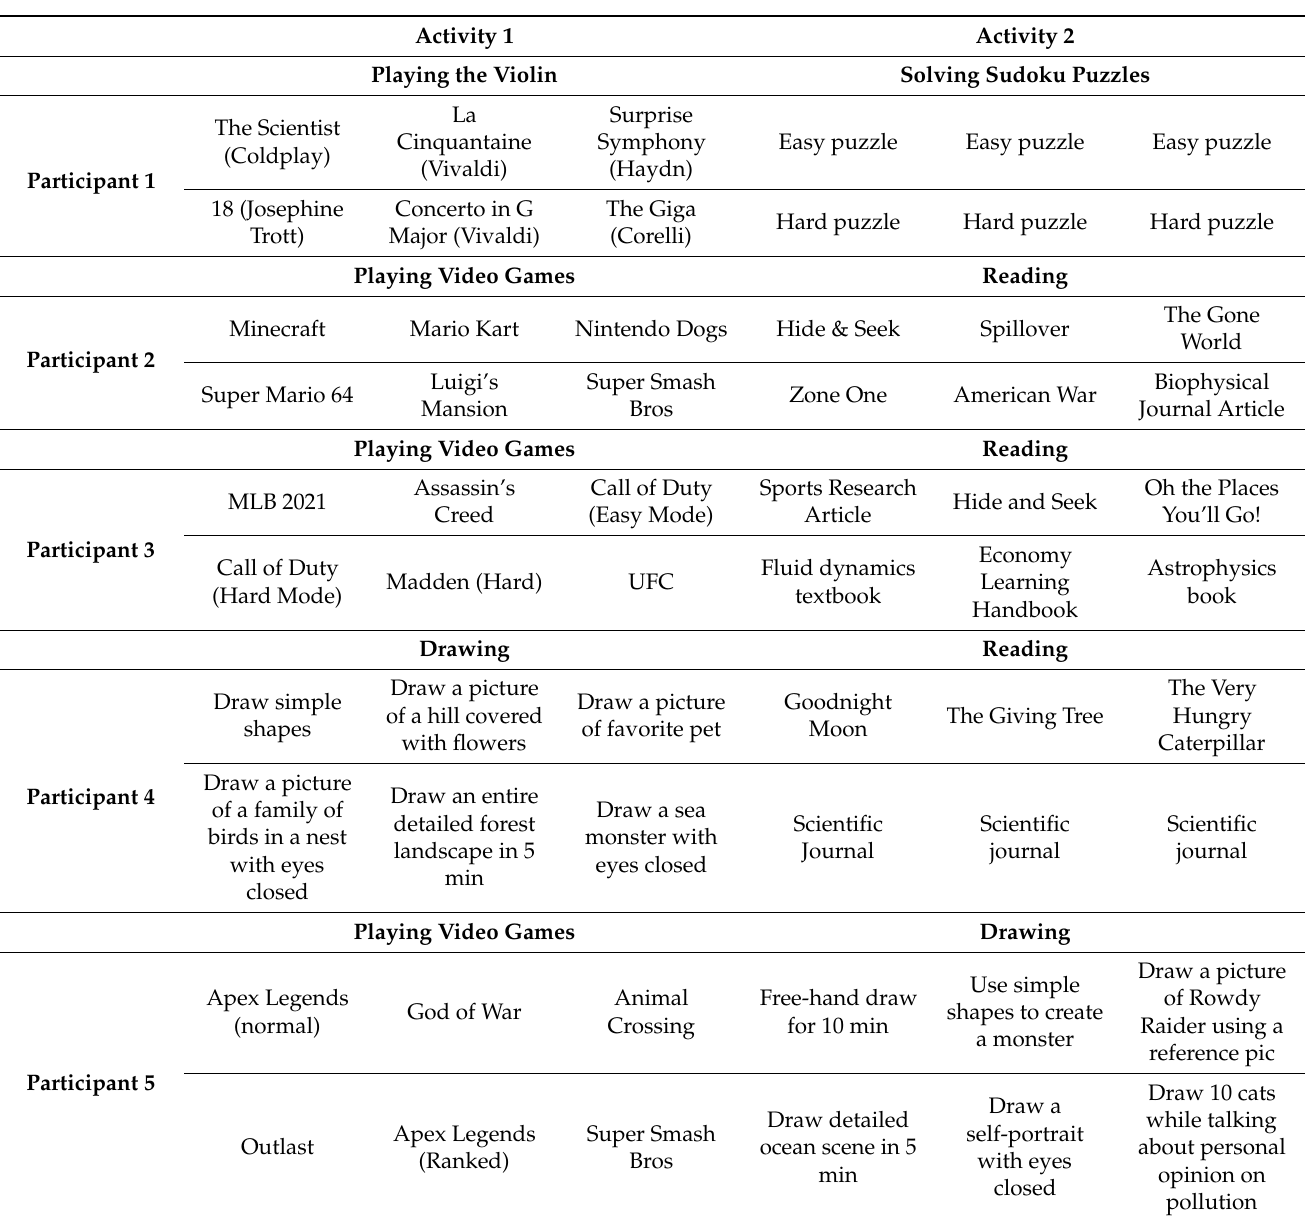
Table 1. Summary of activities and embedded tasks completed by the